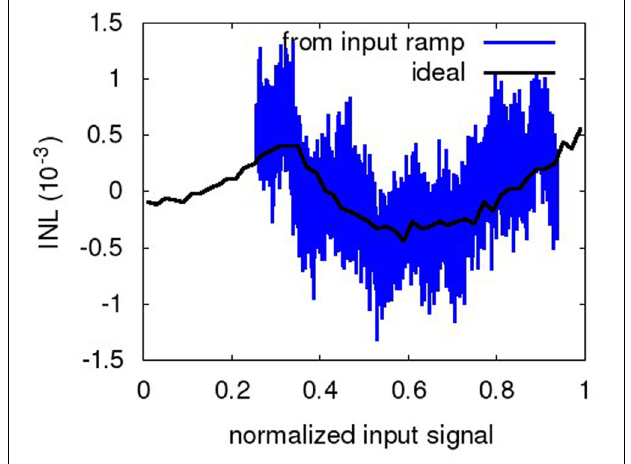
FIGURE 7 | Histogram of the digitized NEF output minus ideal analog input (both normalized to a dynamic range 0..1) during the time slice 2.9 to 3.4s of the output wave in Figure 6 (i.e., the settled portion of the first DC input).